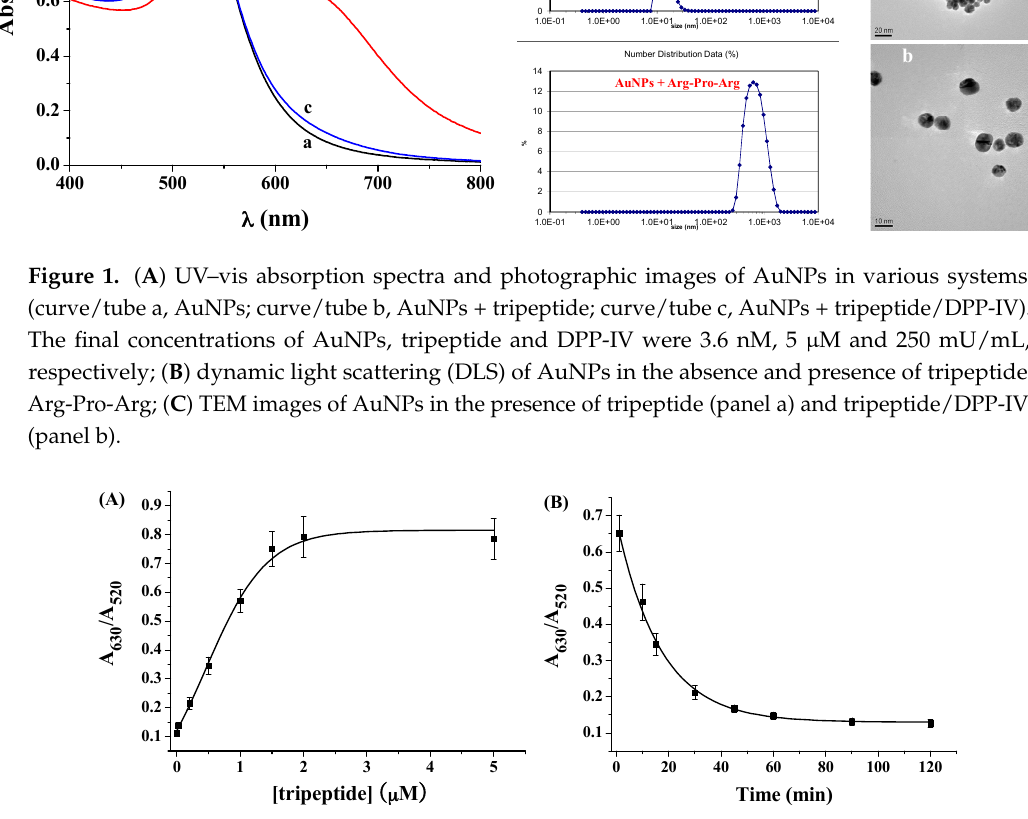
Figure 2. Dependence of the A 630 /A 520 on the tripeptide concentration ( A ) and DPP-IV cleavage time; ( B ) The final concentration of AuNPs was 3.6 nM. The final concentrations of tripeptide and DPP-IV in pane B were 2 μ M and 250 mU/mL, respectively.